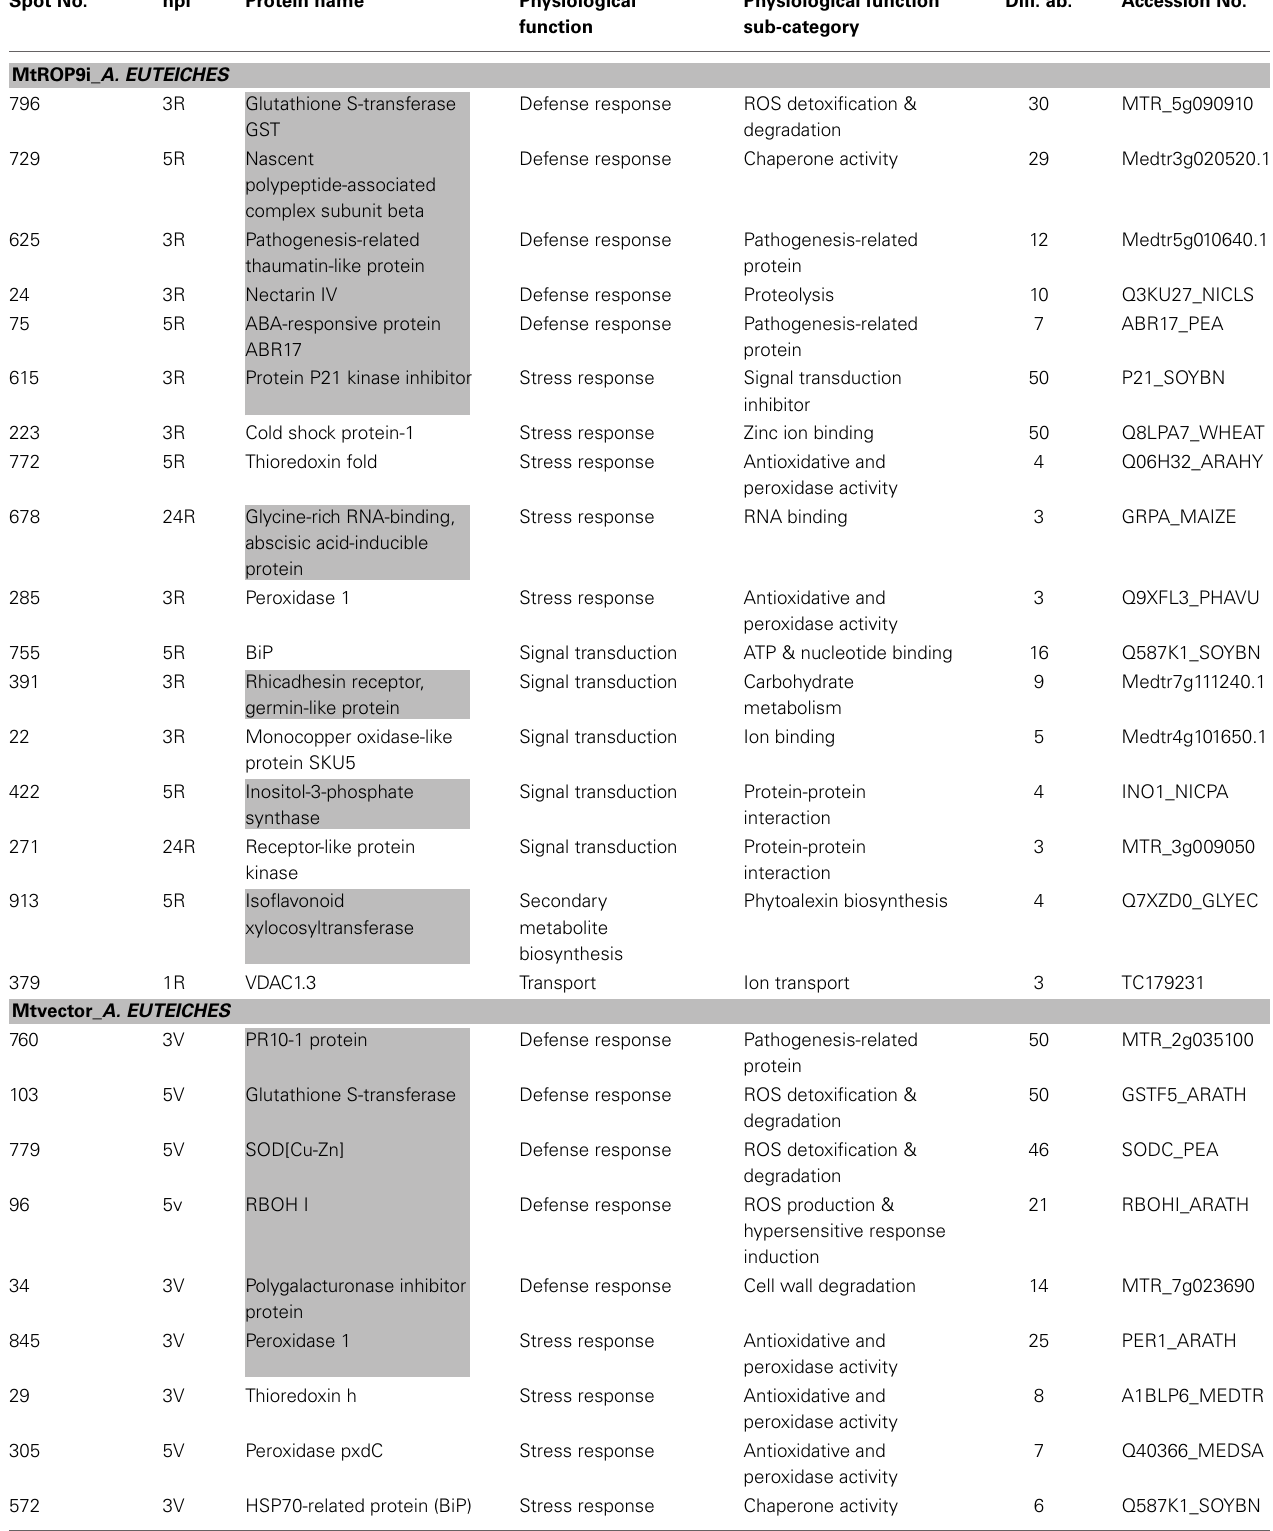
Table 2 | List of proteins with highest induction in abundance for selected physiological categories. Spot No. hpi